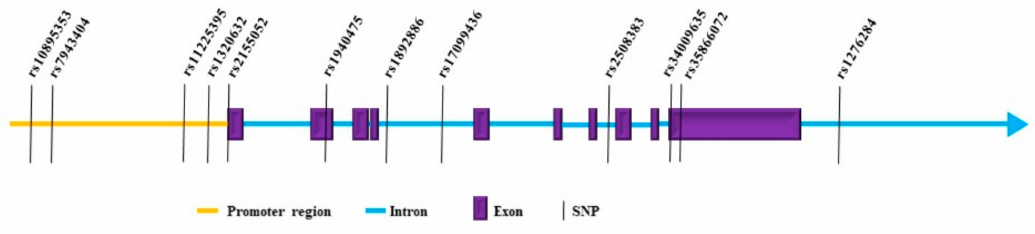
Figure 2. Schematic illustration of MMP8 including the studied single nucleotide polymorphisms